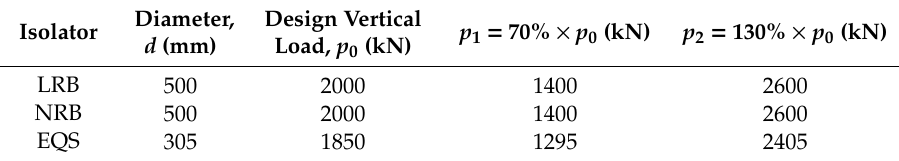
Figure 4. Details of biaxial loading adopted in compressive test of seismic isolators. Table 3. Details of biaxial loading adopted in compressive test by type of seismic isolators.